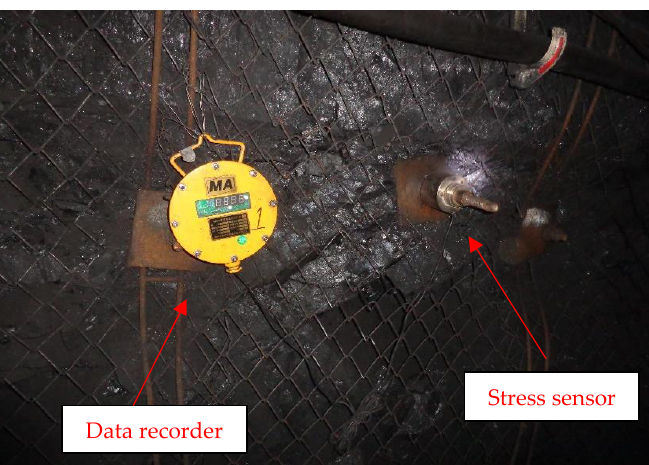
Figure 11. In situ installation of on-line substations for monitoring bolt resistances.